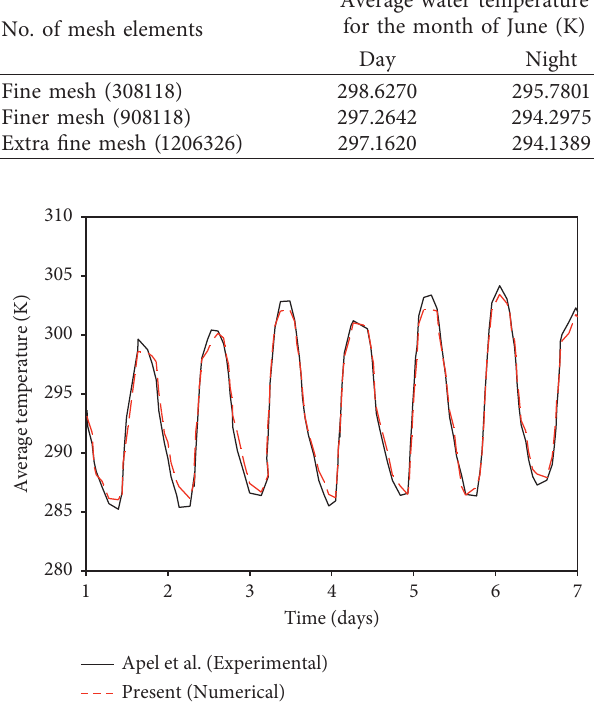
Figure 2: Comparison of present numerical study with experi- mental results of Apel et al. [14].